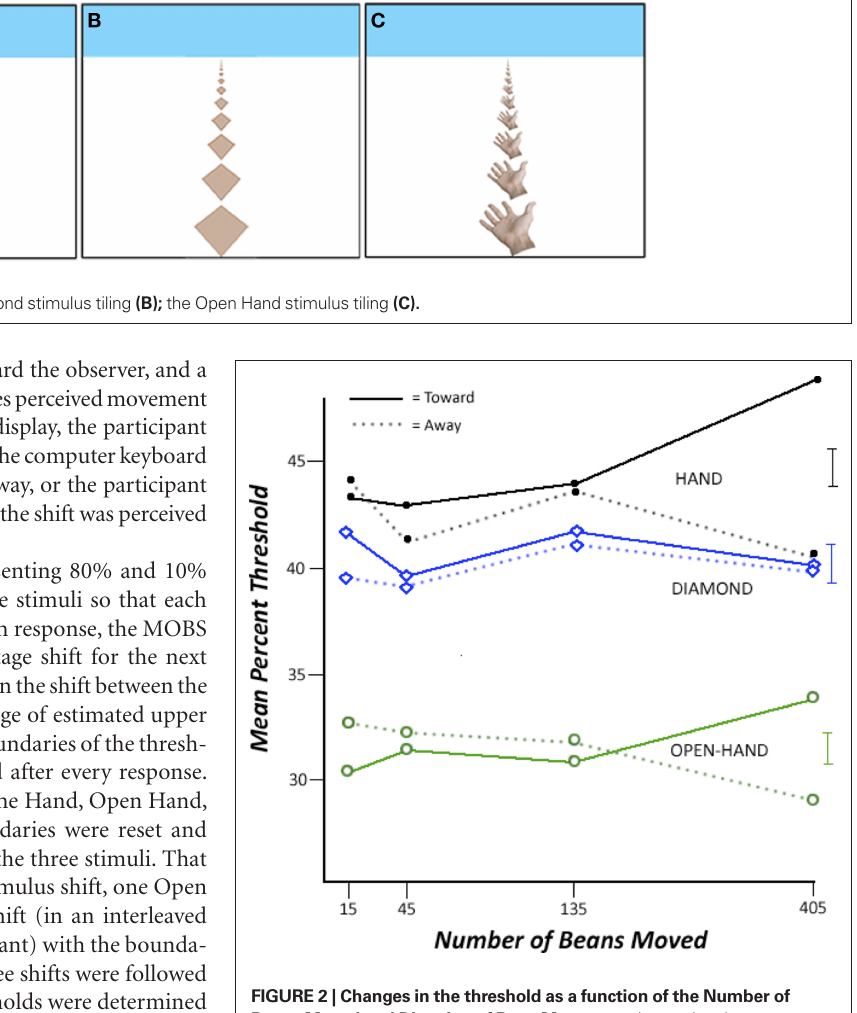
Figure 2 | Changes in the threshold as a function of the Number of Beans Moved and Direction of Bean Movement. Increasing the percentage shift presents information more consistent with a “toward” interpretation of the shift, whereas decreasing the percentage shift presents information more consistent with an “away” interpretation of the shift. Thus, finding a larger mean percent shift with an increase in the number of beans moved in the Toward direction indicates that information more consistent with toward movement is required to perceive the shift as motion toward. Standard error bars for the 405 beans condition are on the far right of the